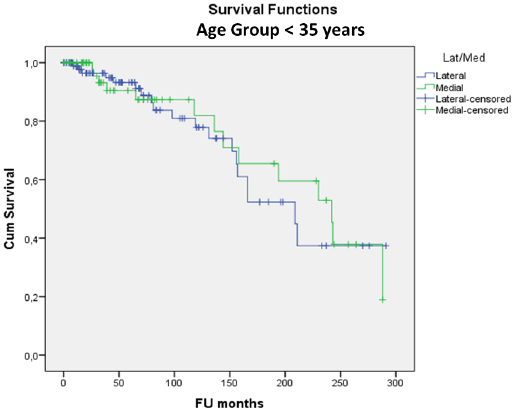
Fig 4. Kaplan-Meier cumulative survivorship of MAT in the < 35 years at surgery group – lateral/medial: no statistically significant difference between lateral (blue line) and medial (green line) MAT (p =